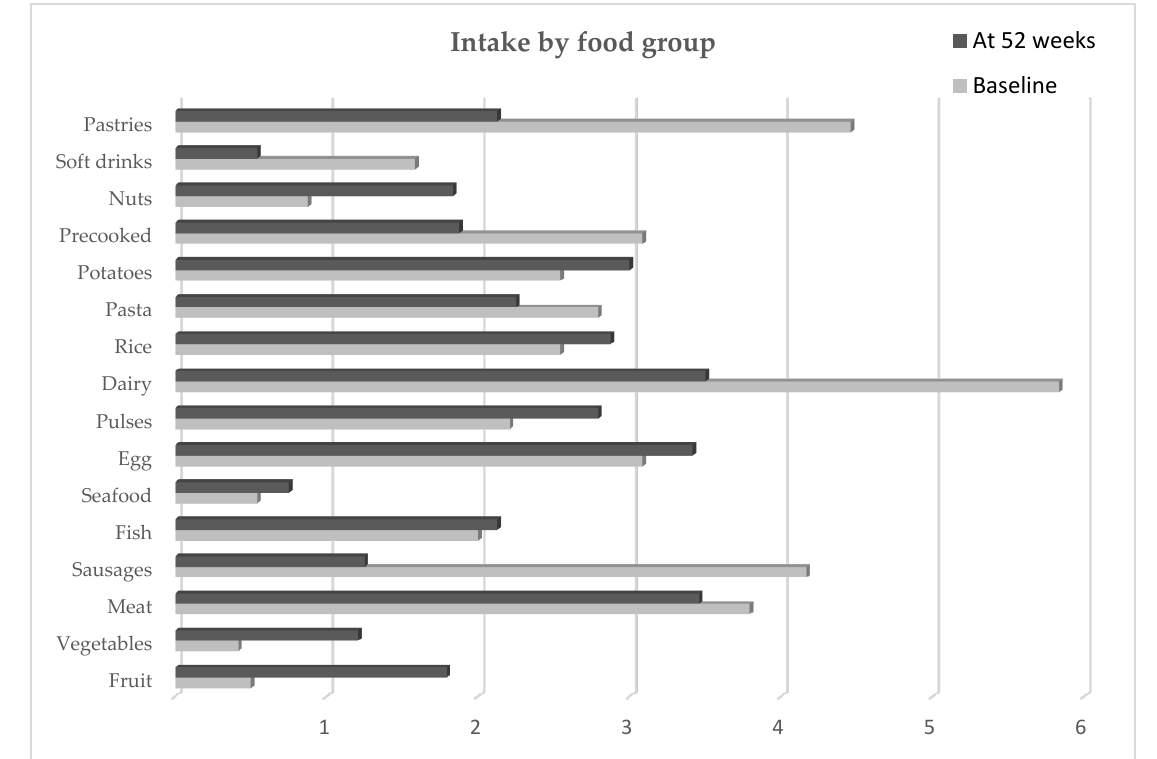
Figure 1. Intake by food group. Data are shown as medium value of servings/week, excepting fruit and vegetables, servings/day.